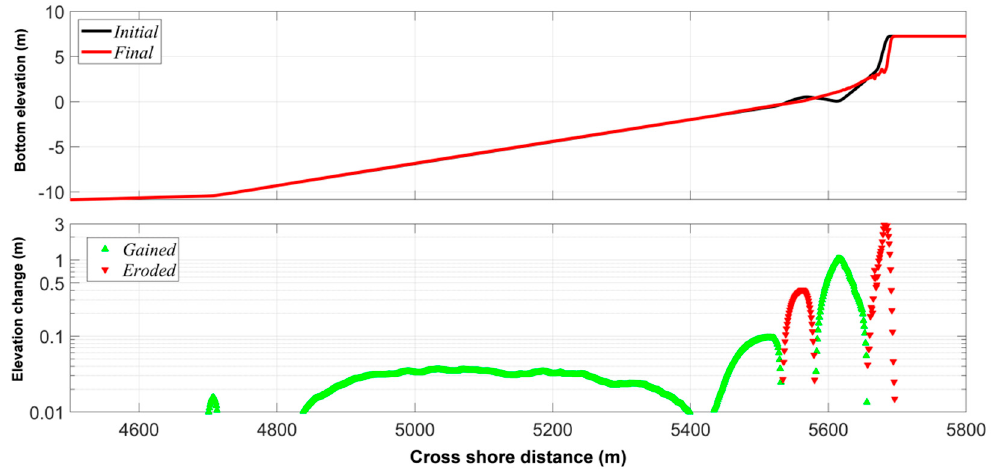
Figure 7. ( a ) Initial and final topo-bathymetric profiles and ( b ) elevation change according to the morphodynamic model.